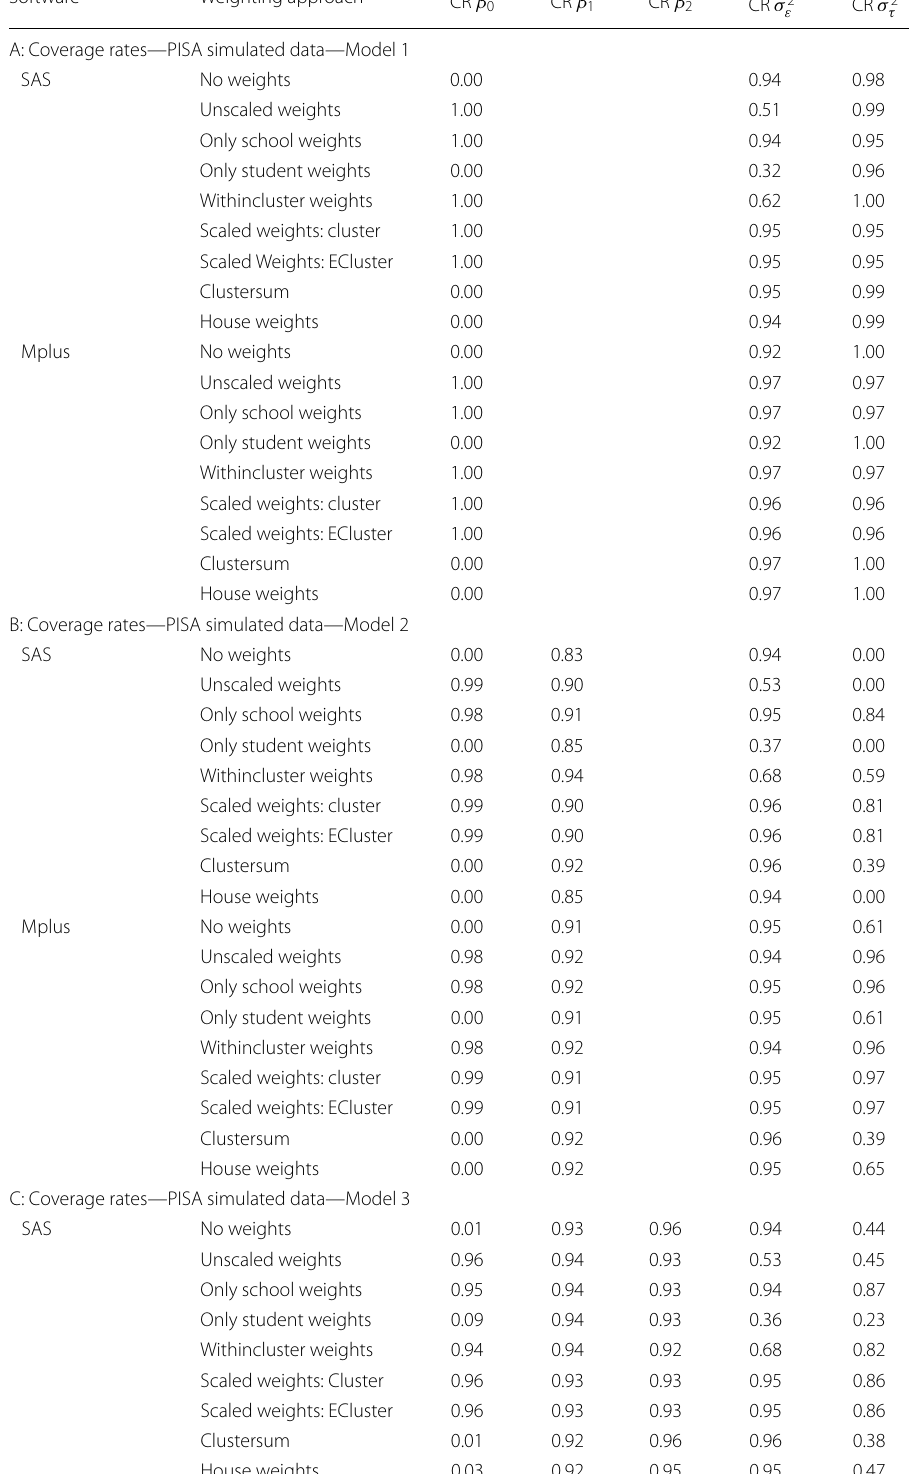
Table 5 Coverage Rates of PISA simulated data